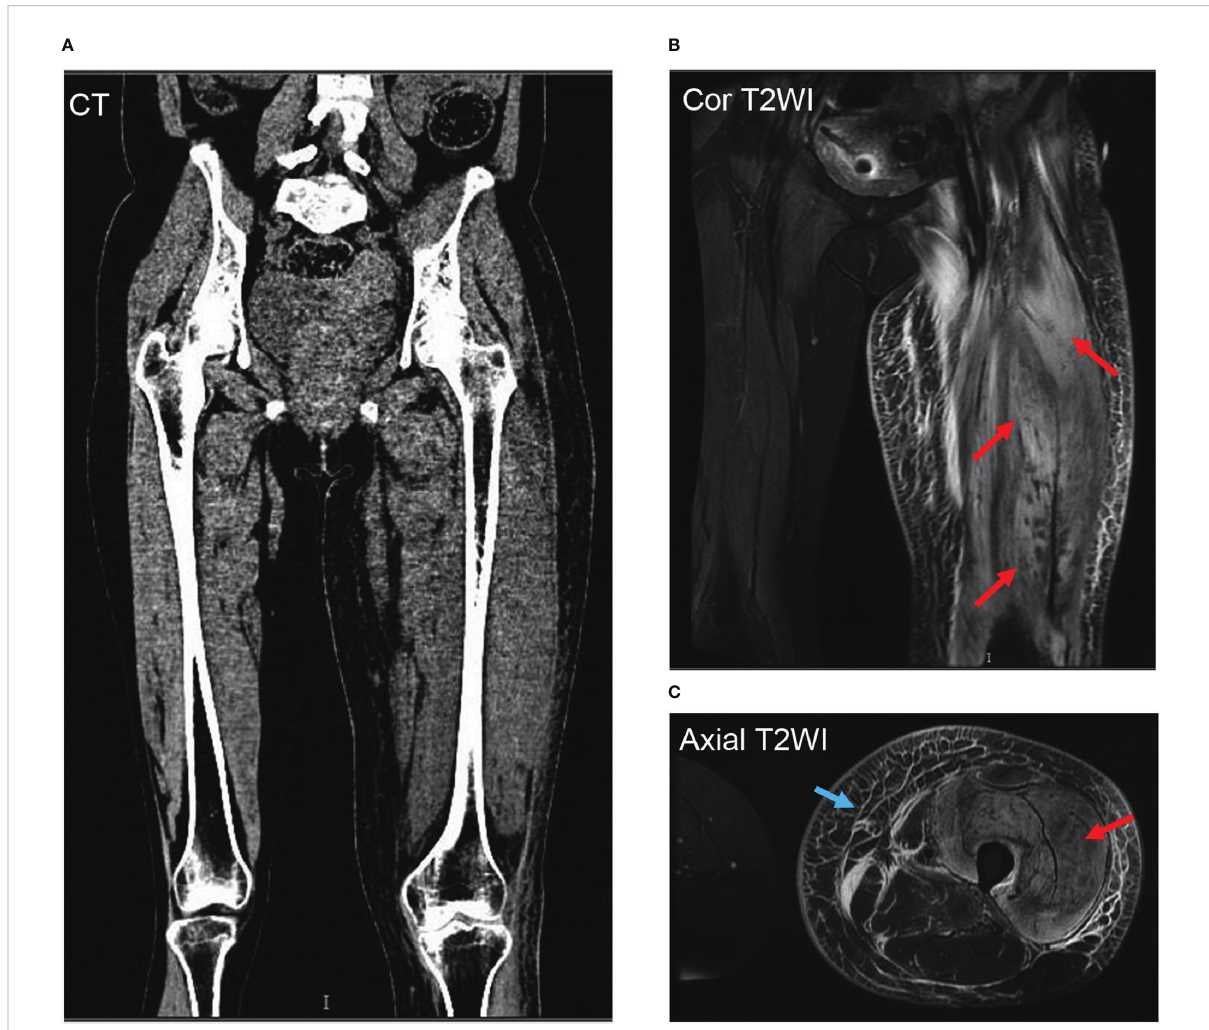
FIGURE 2 Representative thigh muscle images of conventional coronal computerized tomography (CT) image and synthetic weighted images (T2WI) with fat suppression (FS) show severe soft tissue swelling in the left thigh. The CT images (A) con fi rmed muscle swelling but no bone involvement of the femur. The corresponding areas of signi fi cant edema muscle with slightly increased signal intensity are also indicated on a coronal (B) and axial T2WI (C) with red arrows. The swelling muscle shows a slightly increased signal intensity on the T2WI map; A marked T2 hyperintensity occurred in the subcutaneous fascia of the left thigh on axial T2WI -FS with a blue arrow (C)